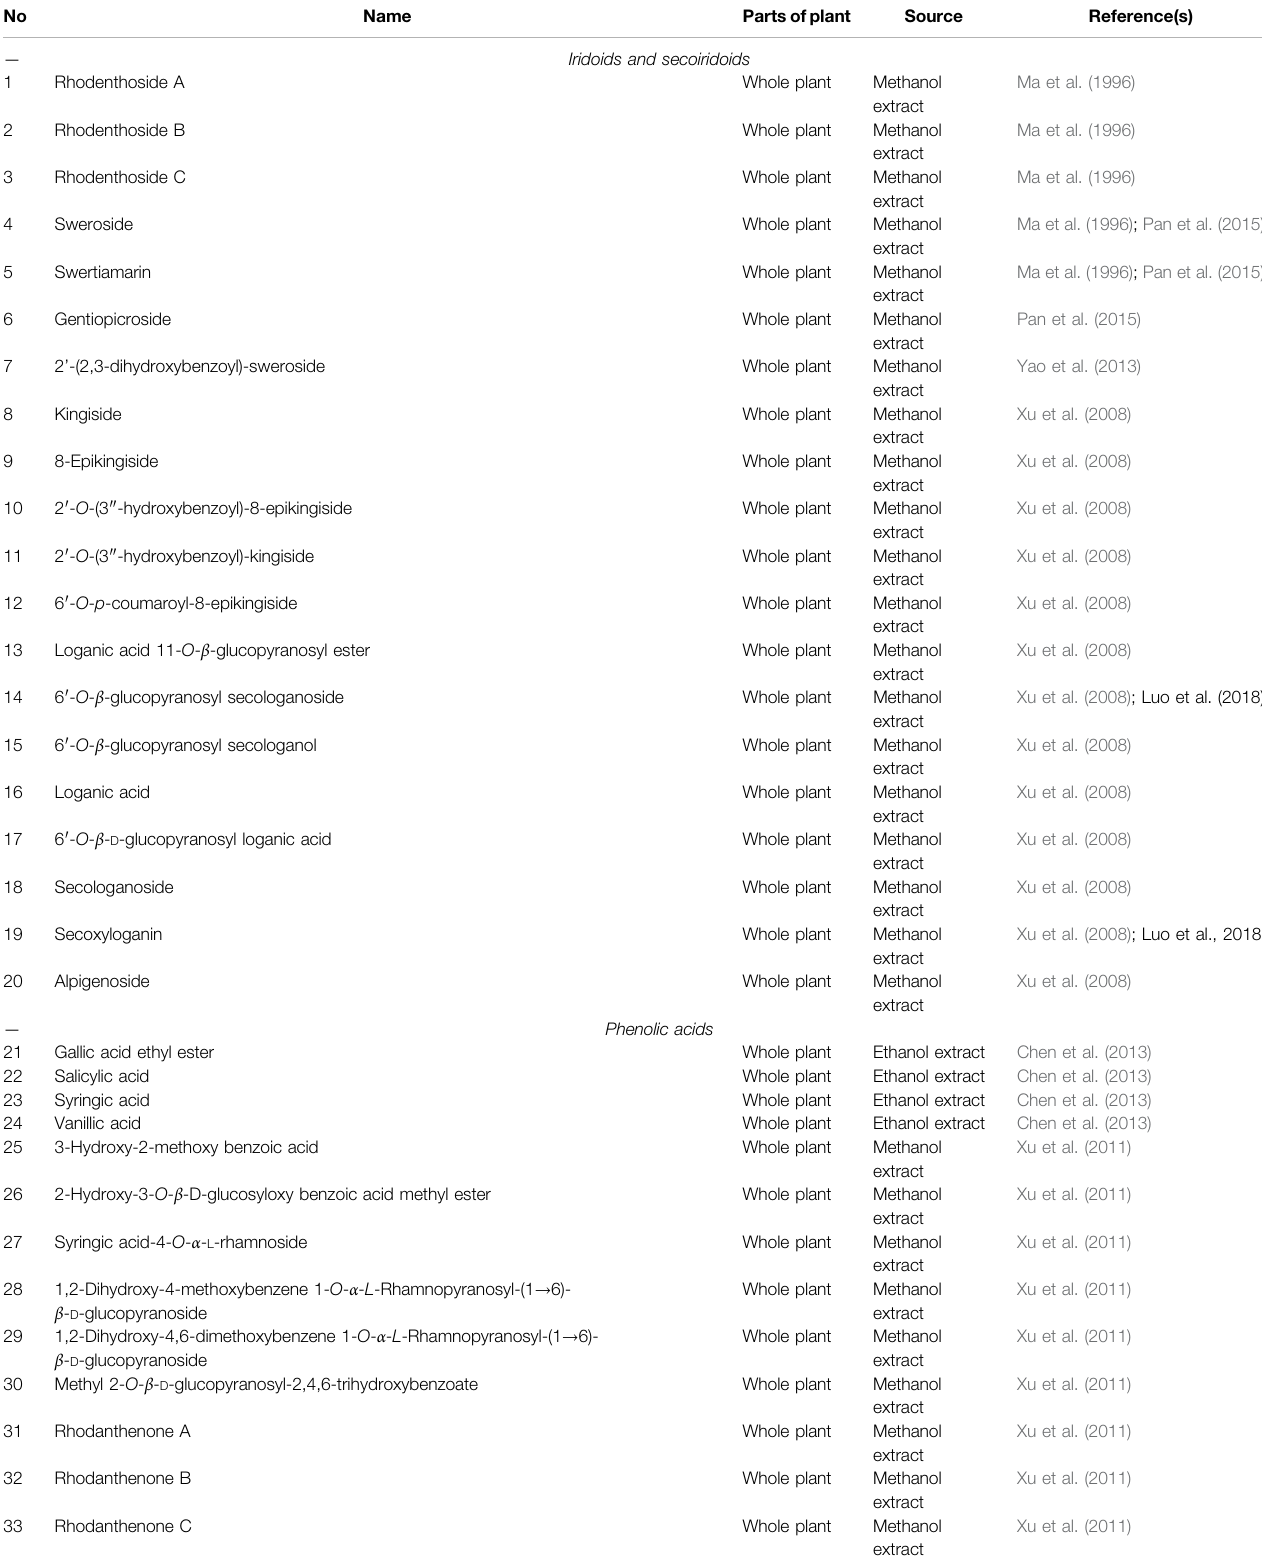
TABLE 2 | The isolated and synthesized compounds from